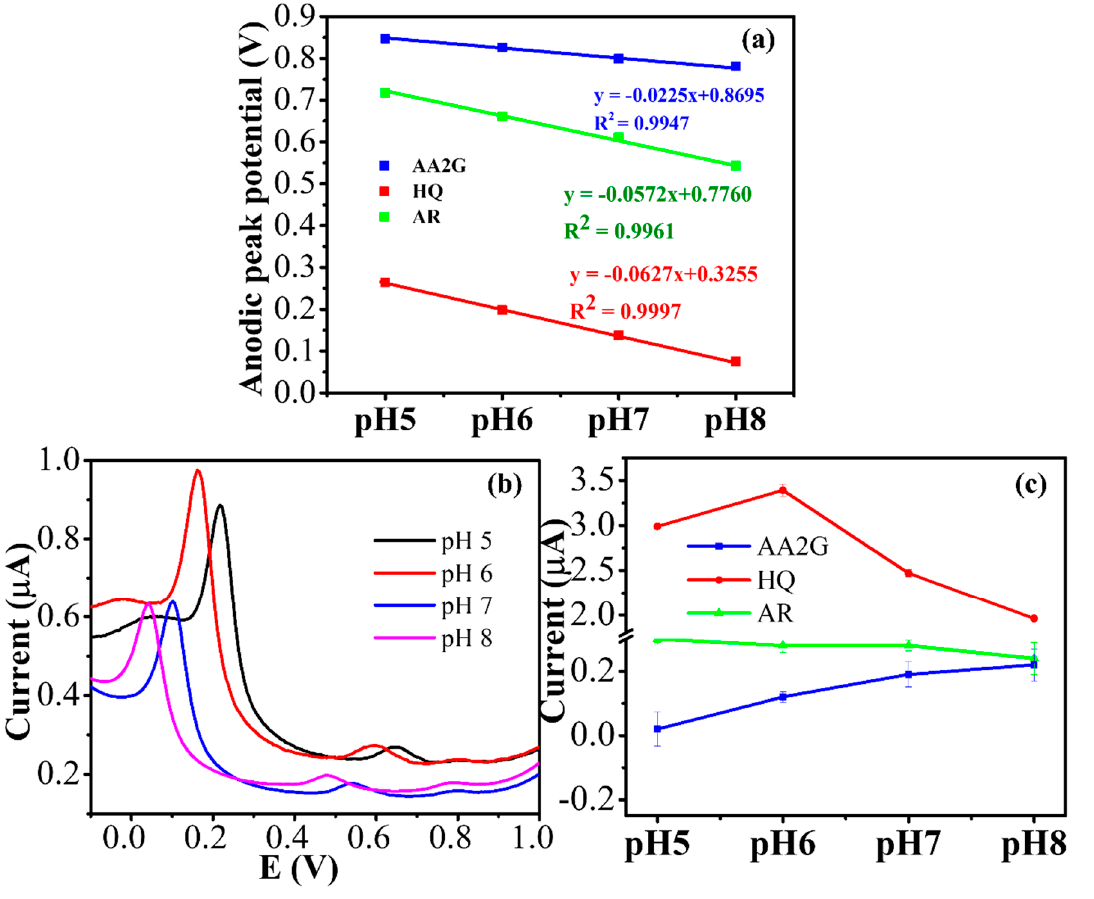
Figure 3. ( a ) A plot of the anodic peak potential of all analytes vs. pHs; ( b ) DPV signals of the HQ (4.54 μ M), AR (1.84 μ M) and AA2G (1.48 μ M) determination in the phosphate buffer solution at different pH values; ( c ) Effect of pH on the peak current of the analytes.